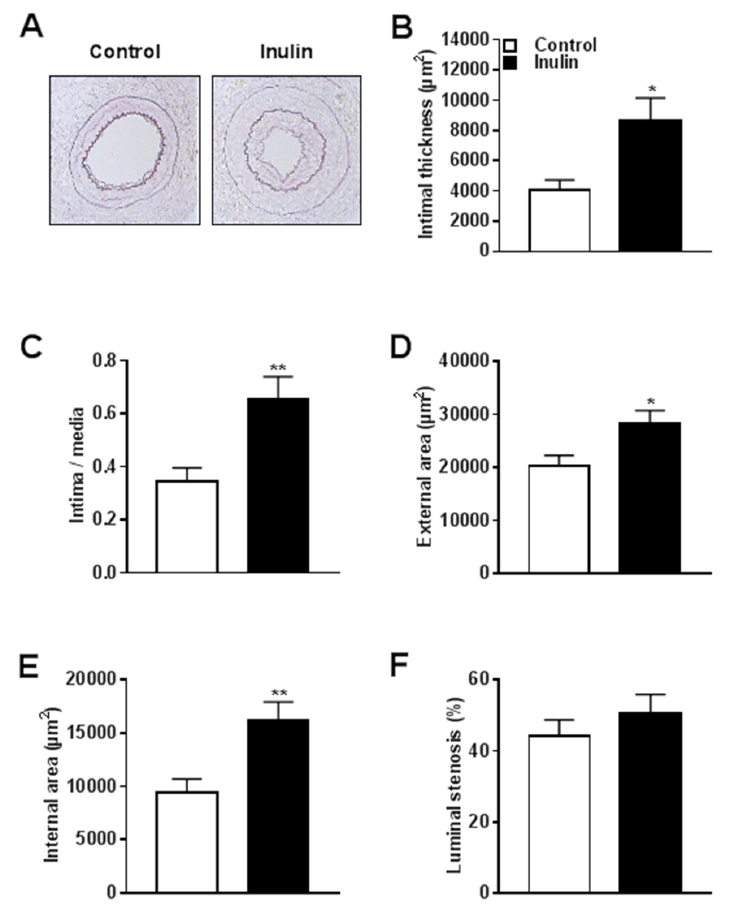
Figure 2. Inulin increased atherosclerotic lesion formation and outward vascular remodeling. ( A ) Representative cross-sections of the cuffed femoral arteries of E3L mice stained with Weigert’s elastin staining visualizing the elastic laminae; ( B ) Quantification of intimal lesion thickening; ( C ) Intima/media ratio; ( D ) External surface area; ( E ) Internal surface area; and ( F ) Percentage of luminal stenosis. Values are presented as means ± SEM ( n = 11–13 mice per group). * p < 0.05, ** p < 0.01 vs. control. Table 2. Experimental measurements including vascular pathology, plasma monocytes, plasma cholesterol, body weight, and food intake.